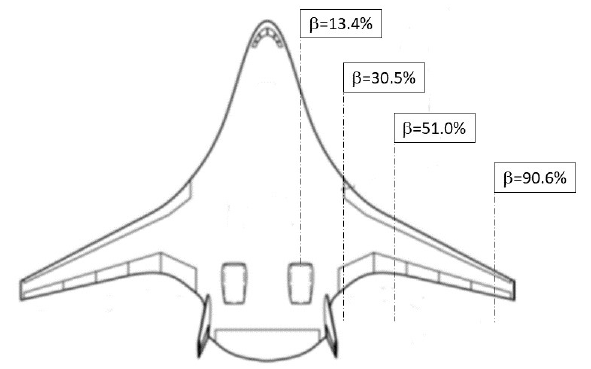
Figure 8. Locations of the four chordwise pressure tap rows on aircraft